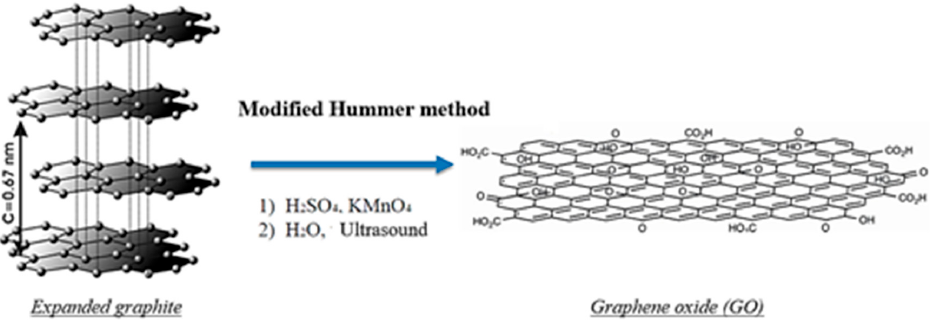
Figure 11. Scheme for synthesis of graphene oxide.